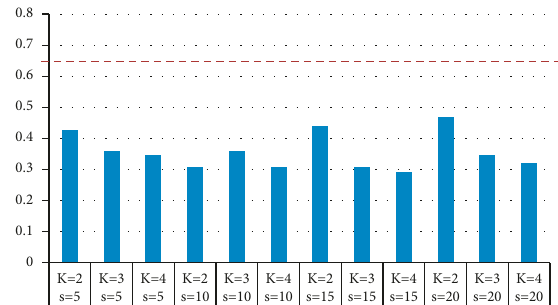
Figure 6: Specificity of CBCD on GS with a threshold 0.005.